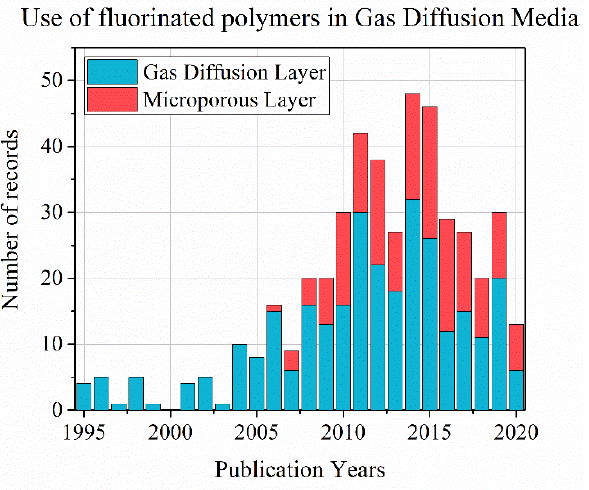
Figure 3. Track of records related specifically to the use of fluorinated polymers in gas diffusion media for PEMFCs.